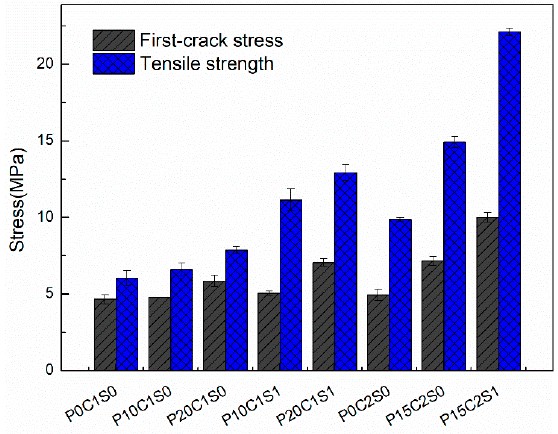
Figure 19. First-crack stress and tensile strength of the prestressed TRM specimens. The effect of prestress can be explained by referring to Figure 20. Point O is the origin of the tension force N with respect to displacement l . The curve includes three distinctive stages, i.e.,